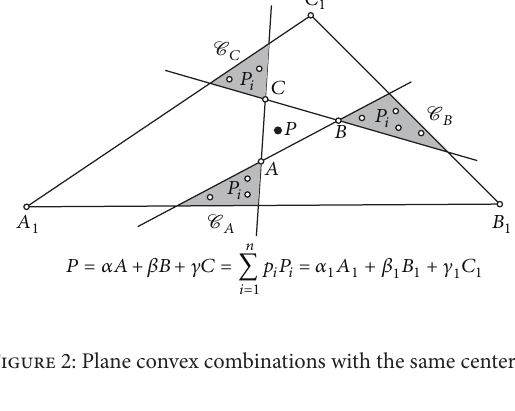
Figure 2: Plane convex combinations with the same center 𝑃